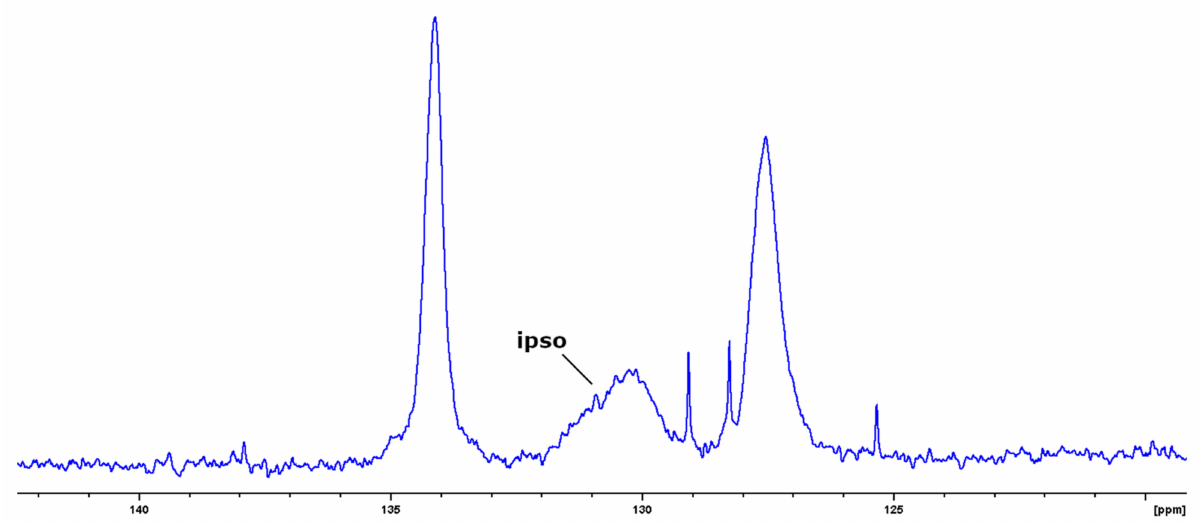
Figure 3. Solid state 13 C NMR spectrum of III. The redundant and broad signals of ipso carbon of phenyl groups indicates the presence of defects in the ladder structure. This can be confirmed by 29 Si NMR spectroscopy. The solid state NMR spectra are given in Figure